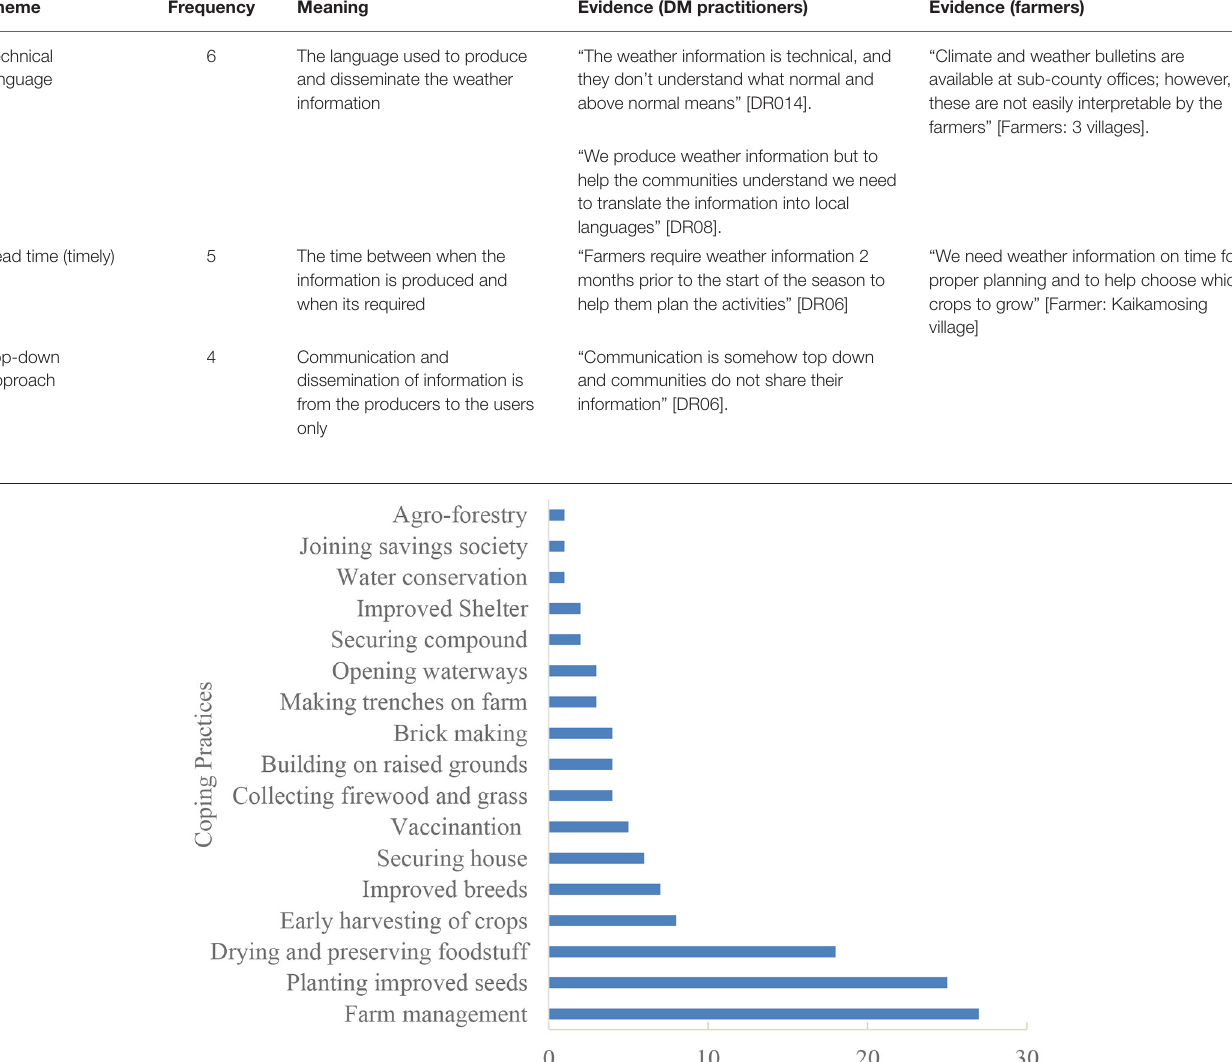
TABLE 4 | Barriers that hinder useful information becoming usable in the context of smallholder